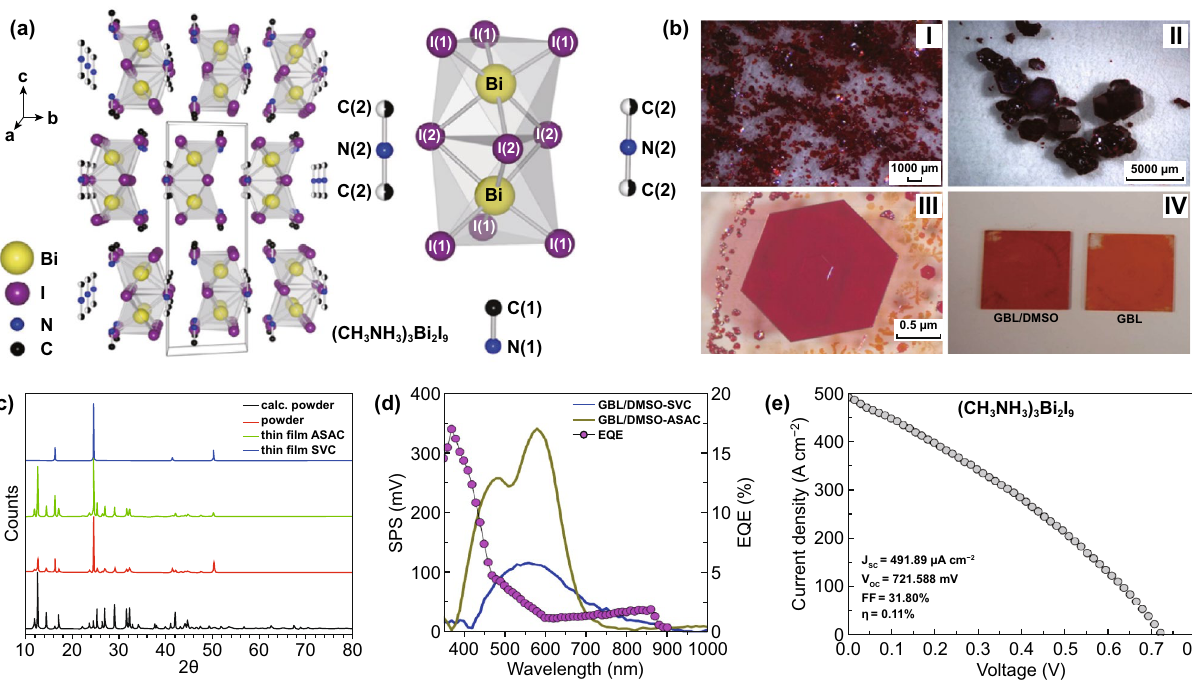
Fig. 11 a A representation of the layered structure of (CH 3 NH 3 ) 3 Bi 2 I 9 , characterized by isolated [Bi 2 I 9 ] 3− anions and two crystallographic inequivalent CH 3 NH 3+ cations. b Small single-crystal powder grown from Bi 2 O 3 and CH 3 NH 3 I in concentrated HI (I–III). And (CH 3 NH 3 ) 3 Bi 2 I 9 thin films deposited by the antisolvent assisted crystallization method (ASAC) using GBL/DMSO and GBL as solvents and chlorobenzene as antisolvent (IV). c Diffraction patterns of (CH 3 NH 3 ) 3 Bi 2 I 9 thin films, powder and simulated powder from single-crystal XRD measurements. d EQE of a typical